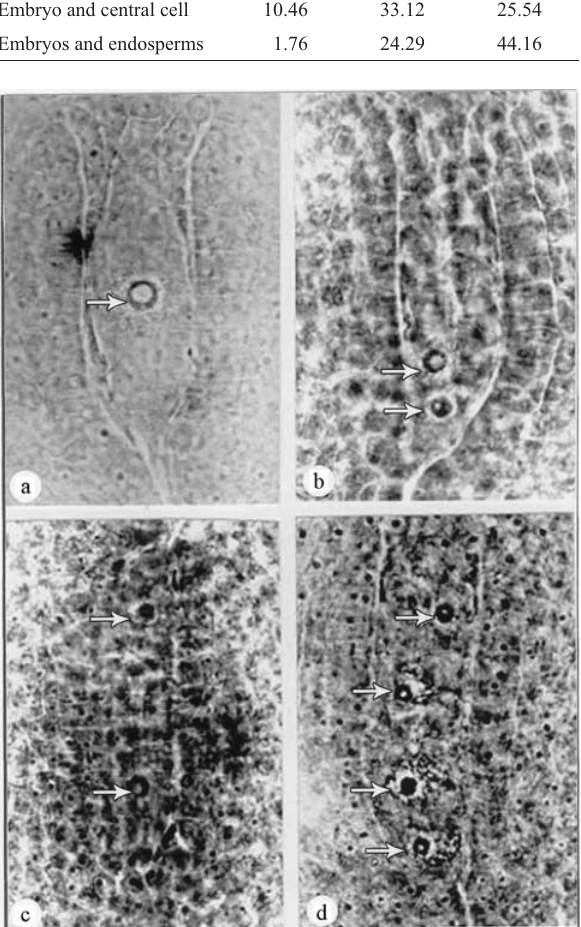
Figure 1 - Embryo sac formation in Eupatorium laevigatum . Key: a = Megasporocyte (500x); b = early 2-nucleate embryo sac (620x); c = late 2-nucleate embryo sac (940x); d = 4-nucleate embryo sac (620x).